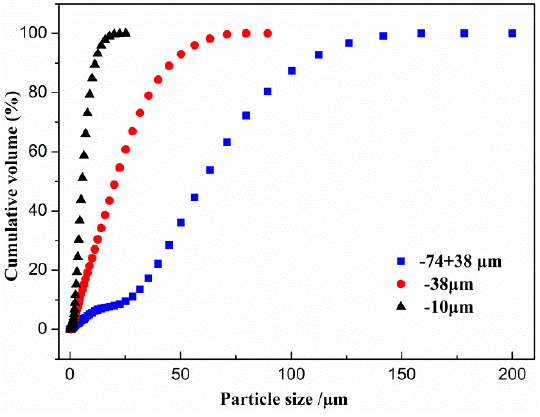
Figure 2. The size distribution of narrow size fractions.